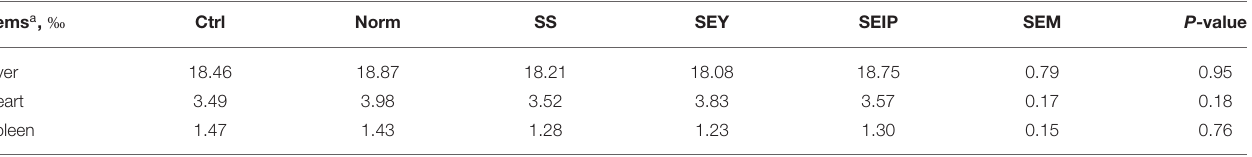
TABLE 7 | Effects of dietary Se sources on organ indexes of laying hens.